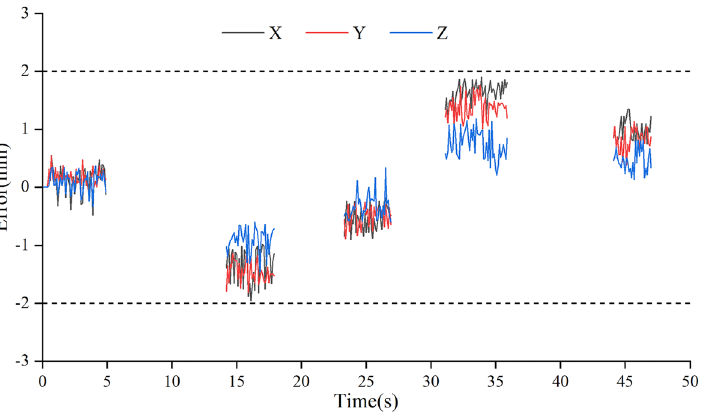
Figure 21. Measured displacement errors in X, Y, Z directions (The figure was generated by Origin 2016 × 64 (https:// www. origi nlab. com/